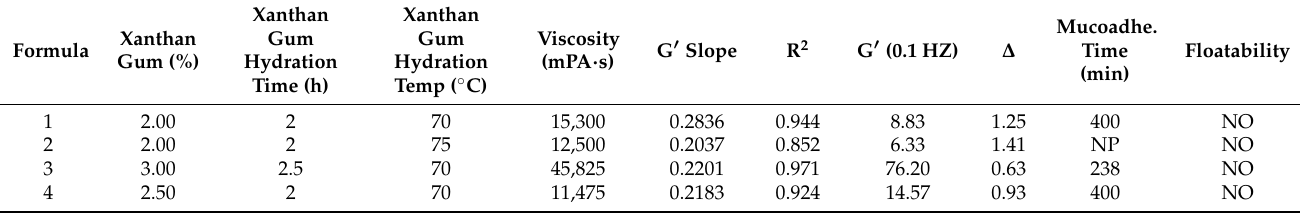
Table 3. Results of the rheological behavior, mucoadhesion time, and